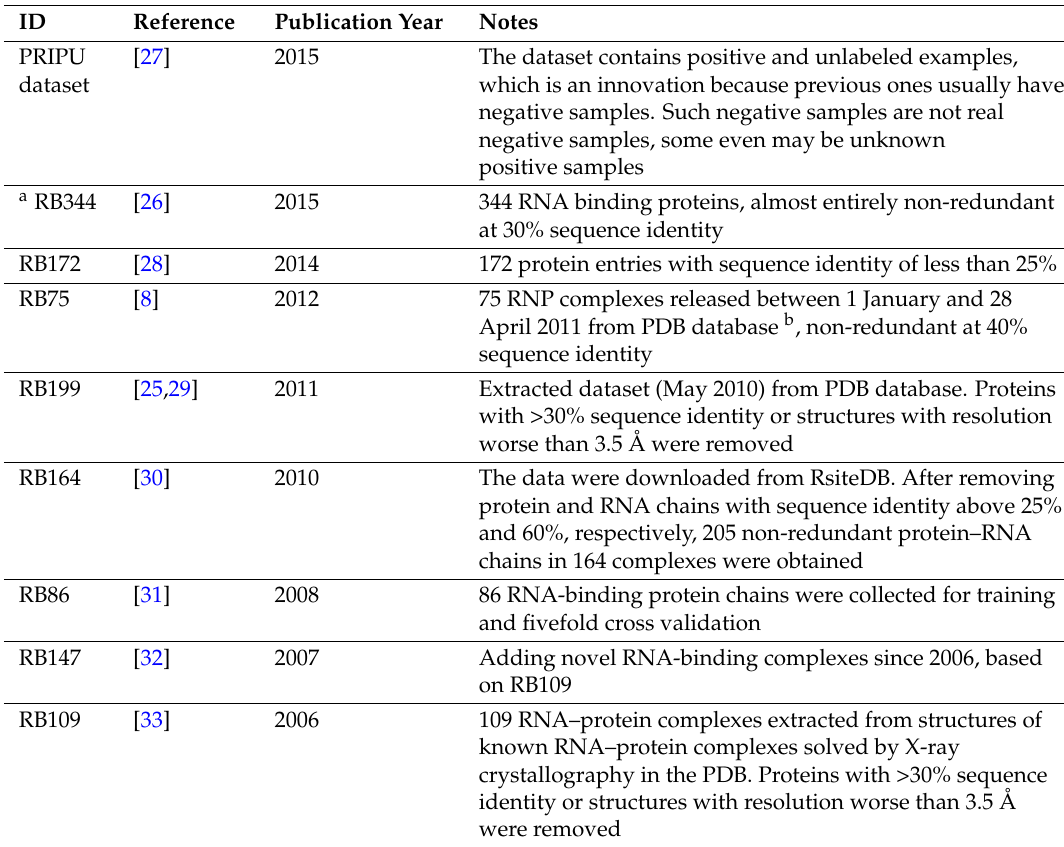
Table 1. Commonly used data sets for RNA-binding sites